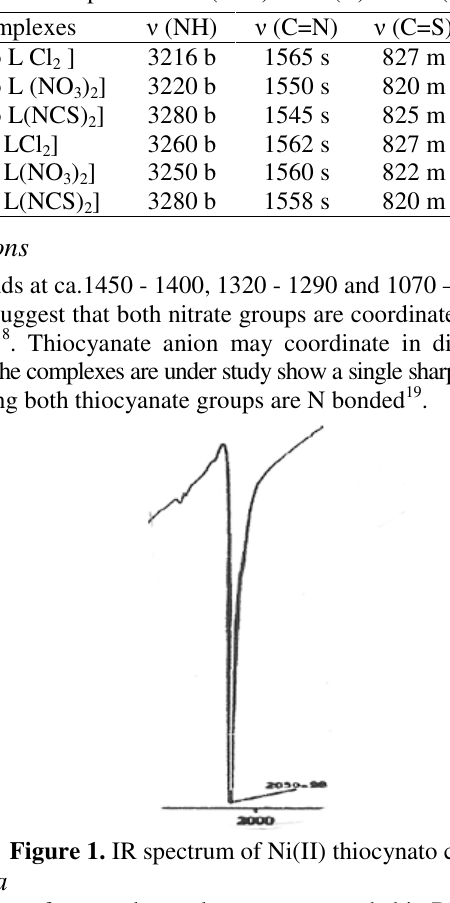
Table 3 . IR spectral data (cm -1 ) of Co(II) and Ni(II) complexes